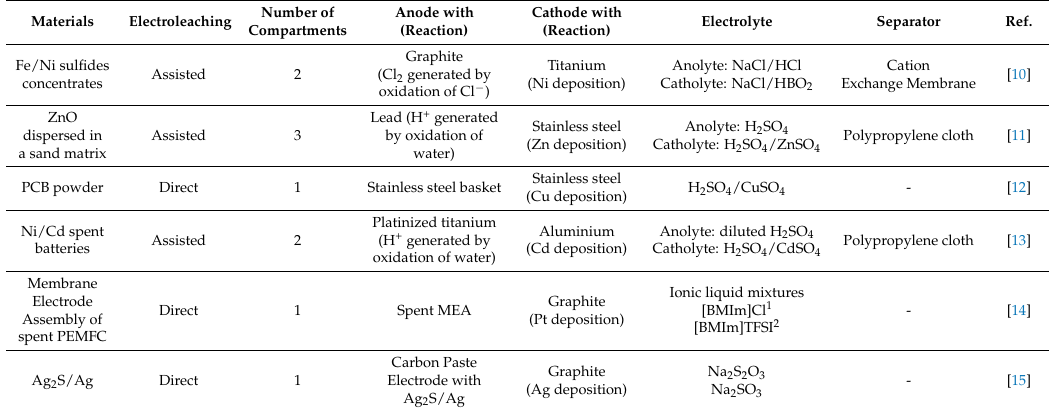
Table 1. Typical examples of coupled electroleaching/electrodeposition in a single-cell.